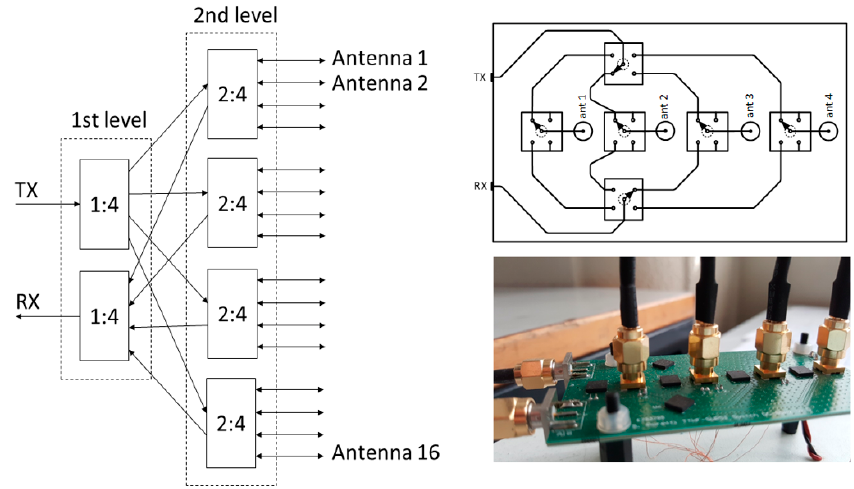
Figure 2. Block scheme of the switching board and photograph of the 2:4 switch module.